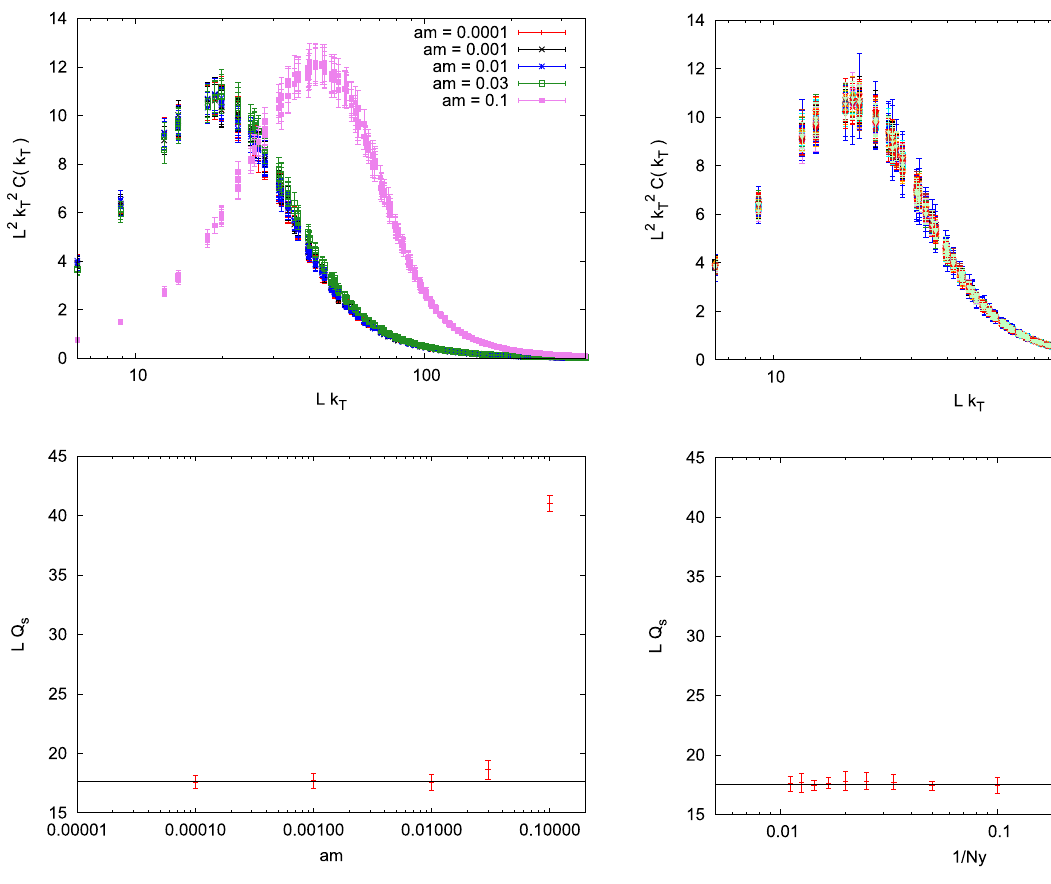
Fig. 8 Top: dependence of the s = 0 momentum-space correlator on the N y parameter. Bottom: dependence of the saturation scale on N y . An infinite N y extrapolation is attempted with the constant fit ansatz f ( 1 / N y ) = b , where b is a fit parameter. Even the data point N y = 1 is compatible with the extrapolated value